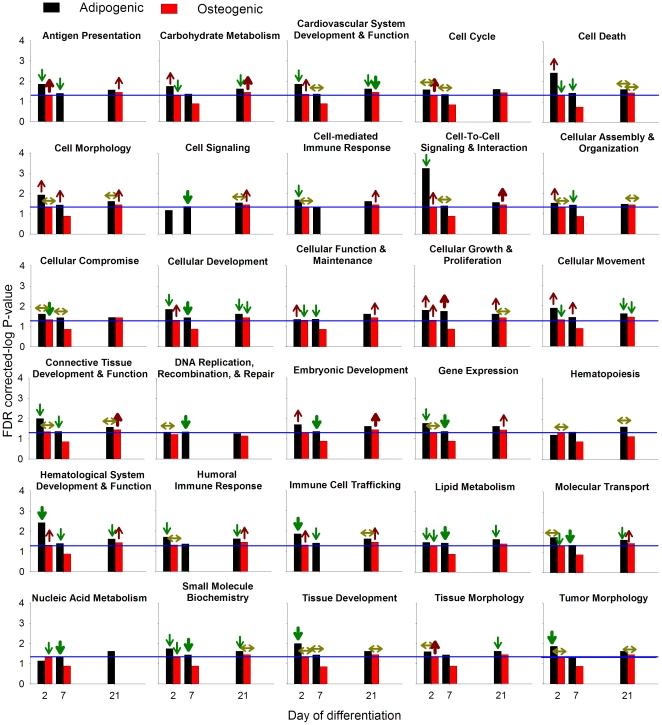
Functional analysis of differentially expressed genes between BMSC and ASC during adipogenic and osteogenic differentiation.Ingenuity Pathway Analysis® (IPA) of BMSC vs. ASC induced to differentiate towards the adipogenic (black bar) and osteogenic (red bar) lineages. The blue line denotes an FDR of 0.05. The arrows denote the overall effect on the function inferred by the gene annotation using IPA ( = highly activated in BMSC vs. ASC;  = activated in BMSC vs. ASC; ↑ = tends to be activated in BMSC vs. ASC;  = highly activated in ASC vs. BMSC;  = activated in ASC vs. BMSC; ↓ = tends to be activated in ASC vs. BMSC; ↔ = not apparent overall activation or inhibition). Functions with “effect on functions” with only 1 gene were not considered for the analysis (i.e., not arrows; see Tables S7, S8, S9, S10 and S11 for details).